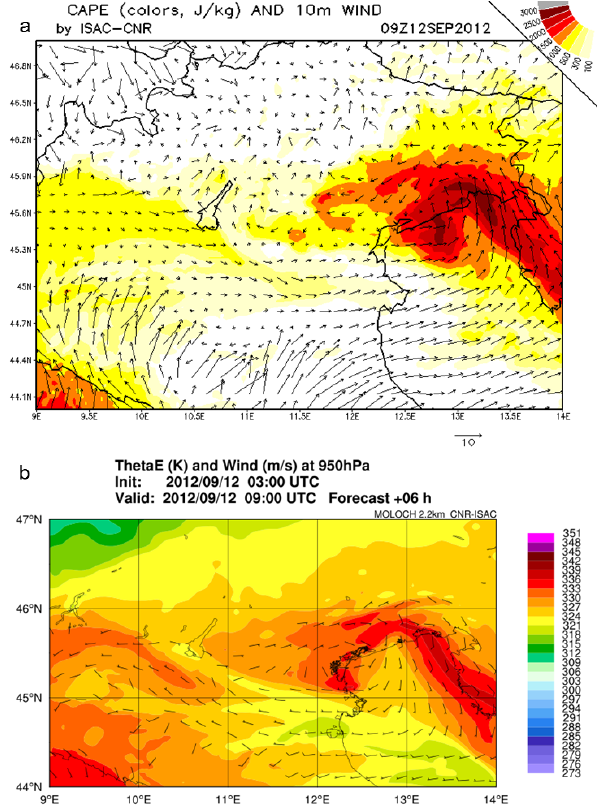
Figure 5. (a) CAPE (Jkg − 1 ) and horizontal wind at 10m by the WRF-ISAC run driven by GFS forecasts starting at 12:00UTC, 11 September; (b) equivalent potential temperature (K) and wind at 950hPa by MOLOCH-ISAC at the 2.3km run driven by GFS fore- casts starting at 00:00UTC, 12 September.